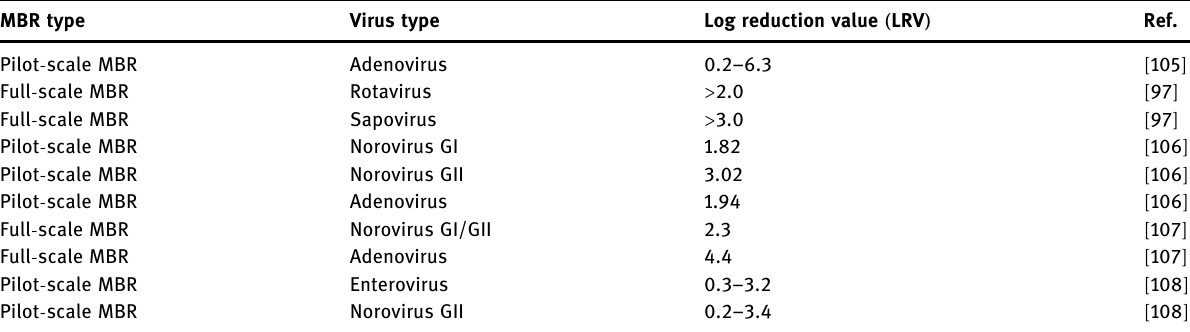
Table 2: Examples of membrane bioreactor systems for virus removal and their LRVs: 2015 – 2020 MBR